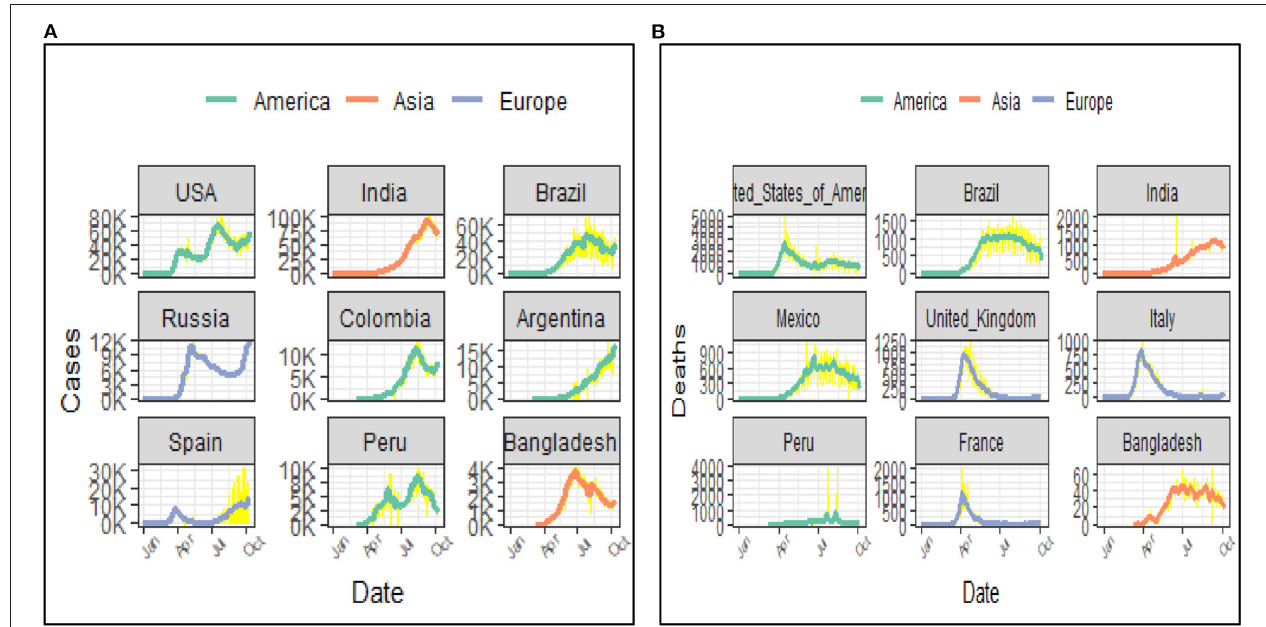
FIGURE 10 | (A) Case pattern over time (7 days average) (top 8 countries and Bangladesh). (B) Death pattern over time (7 days average) (top 8 countries and